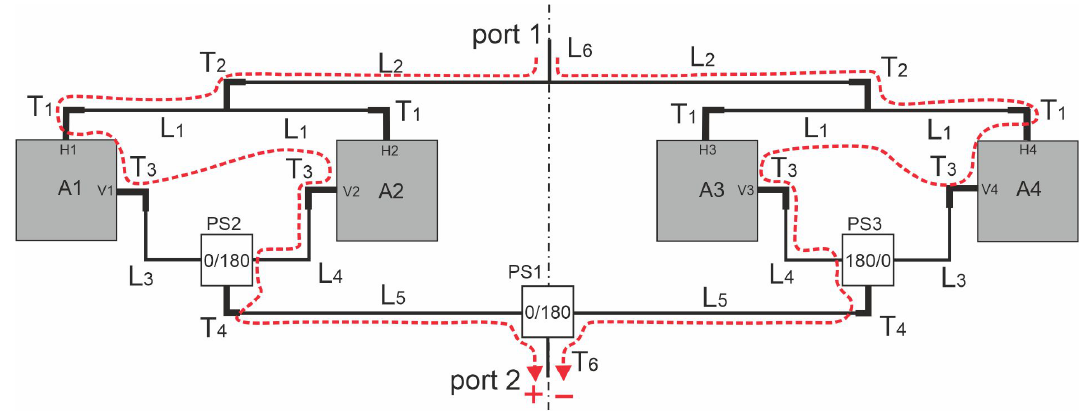
Figure 6. The antenna array diagram for variant 3 of the feeding network.